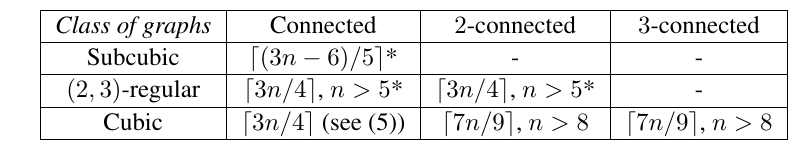
Tab. 1: Proven lower bounds on the number of vertices in a maximum P 3 -packing in a subcubic graph. Tight bounds are marked with